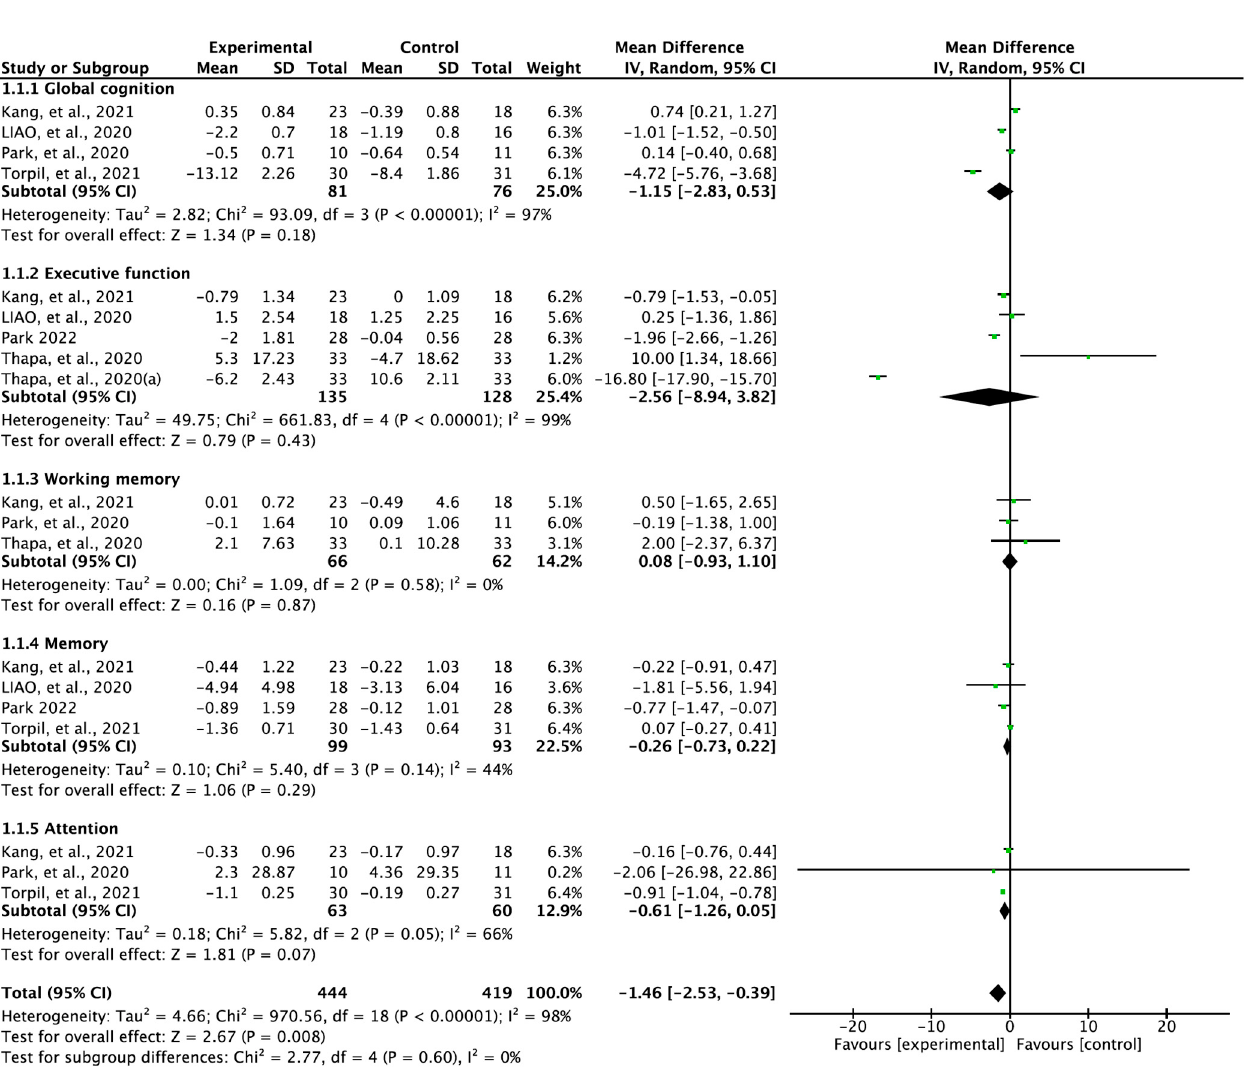
Figure 3. Forest plot studying the effect of virtual reality on cognitive function. Thapa, et al. 2020 (a) Digit Symbol Substitution Test. Kang et al., 2021 [24] , Liao et al., 2020 [25] , Park 2022 [26] , Park et al., 2020 [27] , Thapa et al., 2020 [28] , Torpil et al., 2021 [29] .